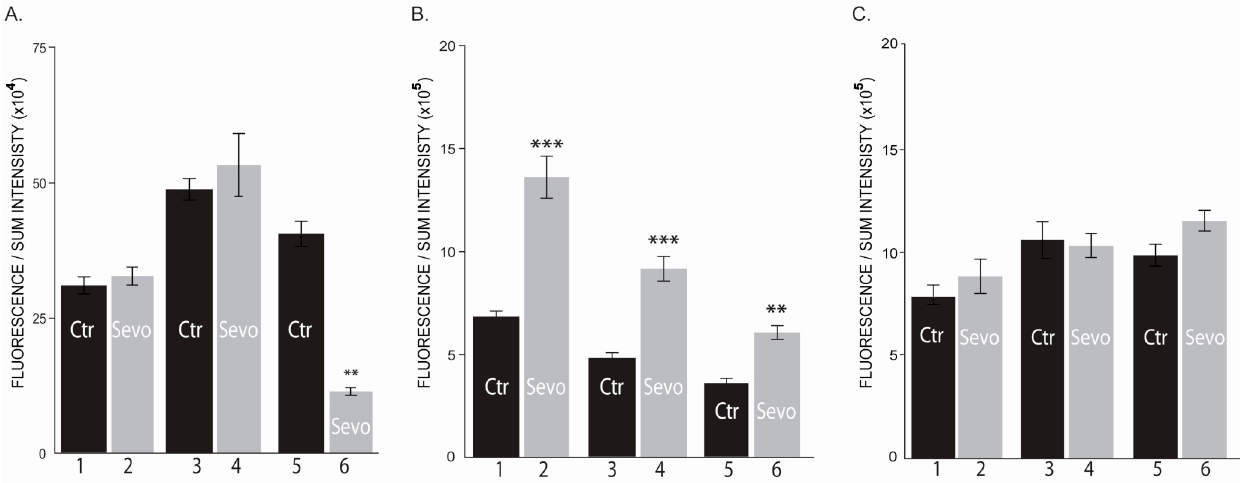
Figure 4. Level of AKT isoforms in MCF-10A. ( A ) AKT1 expression level; ( B ) AKT2 expression level; ( C ) AKT3 expression level (1, 2–6 h; 3, 4–24 h; 5, 6–72 h; Ctr-untreated cells; sevo-treated cells with 2 mM sevoflurane; h-hours). ** p < 0.005; *** p < 0.0005. n = 2.